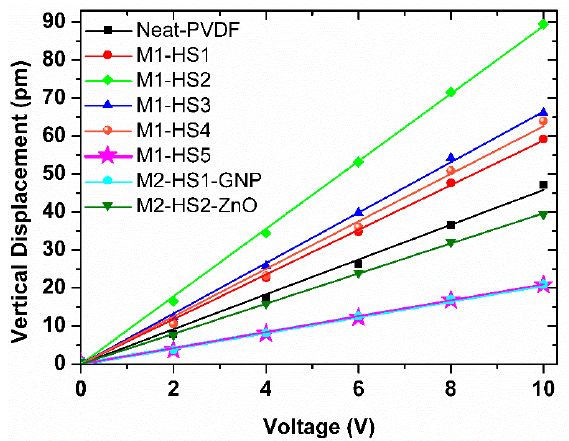
Figure 8. Average amplitude of the vertical displacement measured through PFM as a function of the applied voltage V ac .